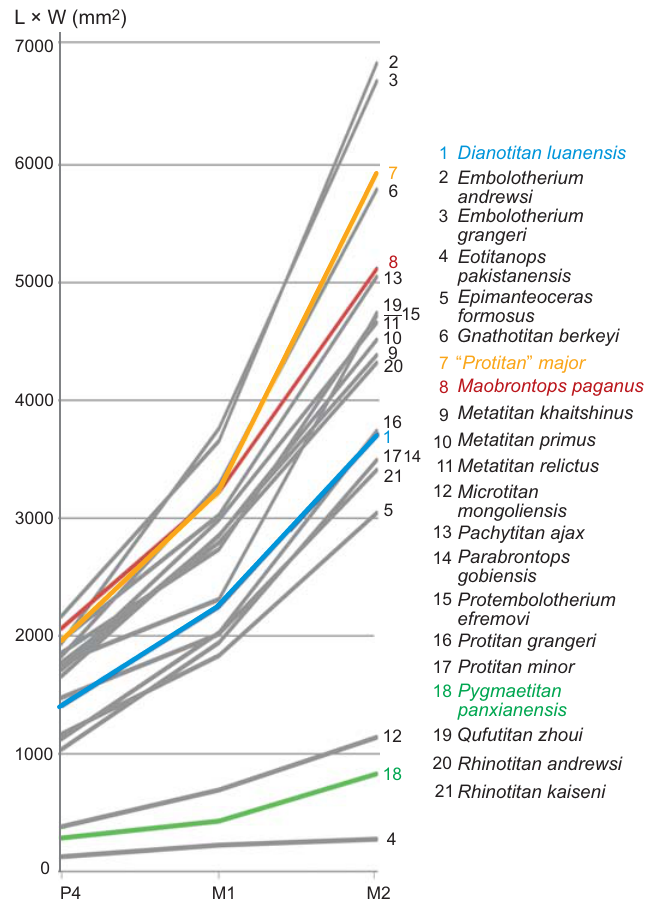
Fig. 5. The size of middle cheek teeth, P4 and M1–2 (L × W), in Asian brontotheres (based on data present in SOM 2). Taxa found in South China are Dianotitan lunanensis (1), “ Protitan ” major (7), Maobrontops paganus gen. et sp. nov. (8), and Pygmaetitan panxianensis